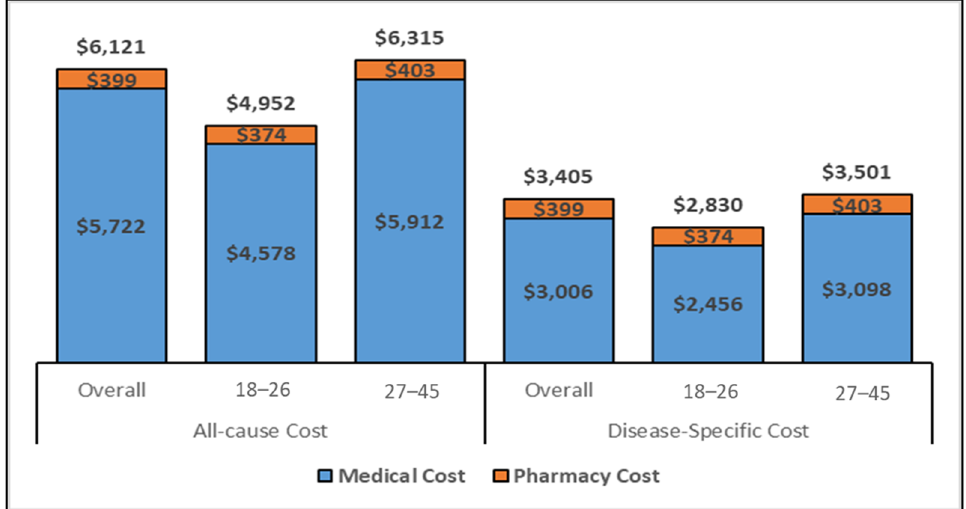
Figure 4. All – cause and disease ‐ specific, 6 – months costs for the overall cohort (Inflated to 2020 USD. Figure 4. All–cause and disease-specific, 6–months costs for the overall cohort (Inflated to 2020